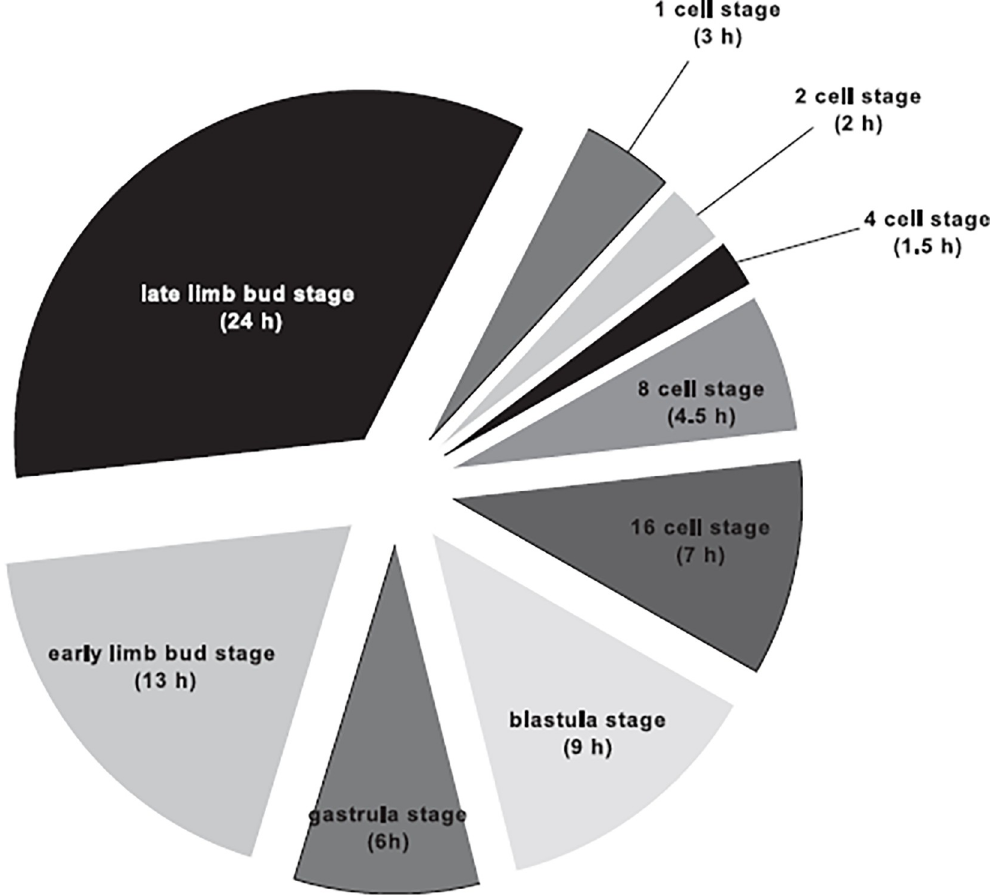
Fig 2. The duration of embryonic stages (1-, 2-, 4-, 8-, 16- cell, blastula, gastrula, and limb bud stages) of Ive ptychoderae . The assigned time of each stage is indicated in